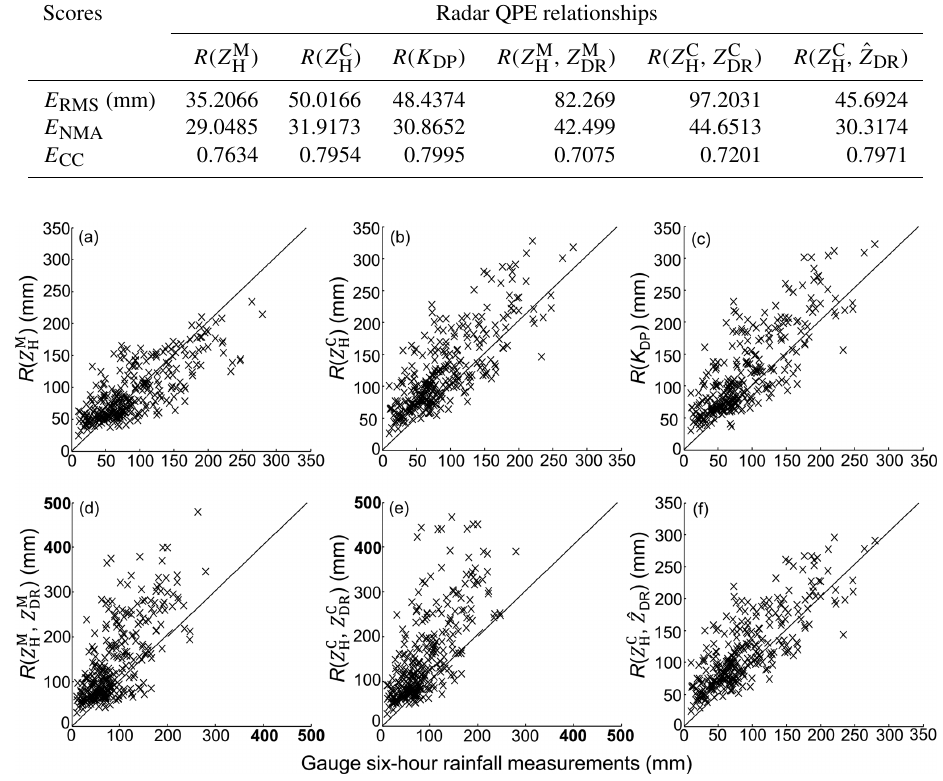
Figure 22. The scattergram of 6h rainfall estimates from radar versus corresponding gauge rainfall measurements. The radar rainfall esti- mates are derived at 22:00UTC, 9 August 2019, using (a) R ( Z M ˆ Z DR ).